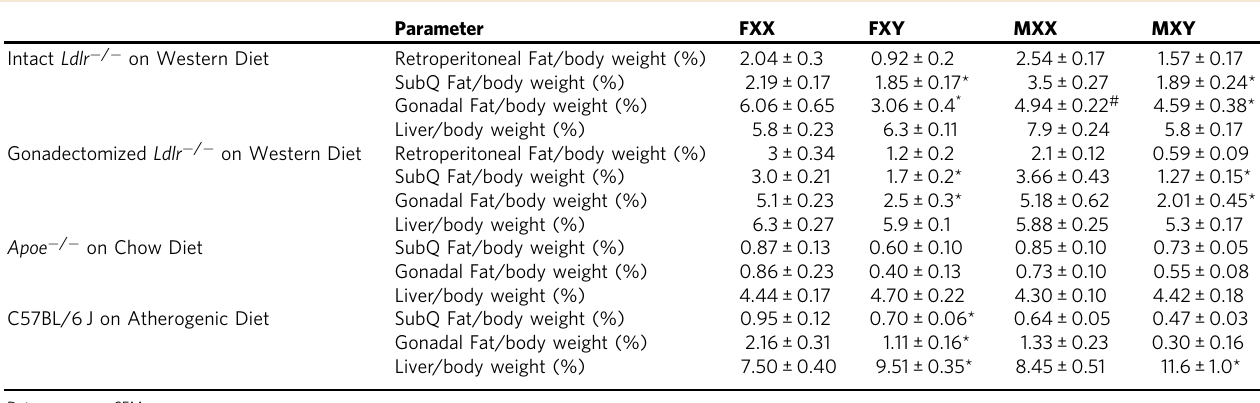
Table 1 Characteristics of mice of each group Parameter Intact Ldlr − / − on Western Diet Retroperitoneal Fat/body weight